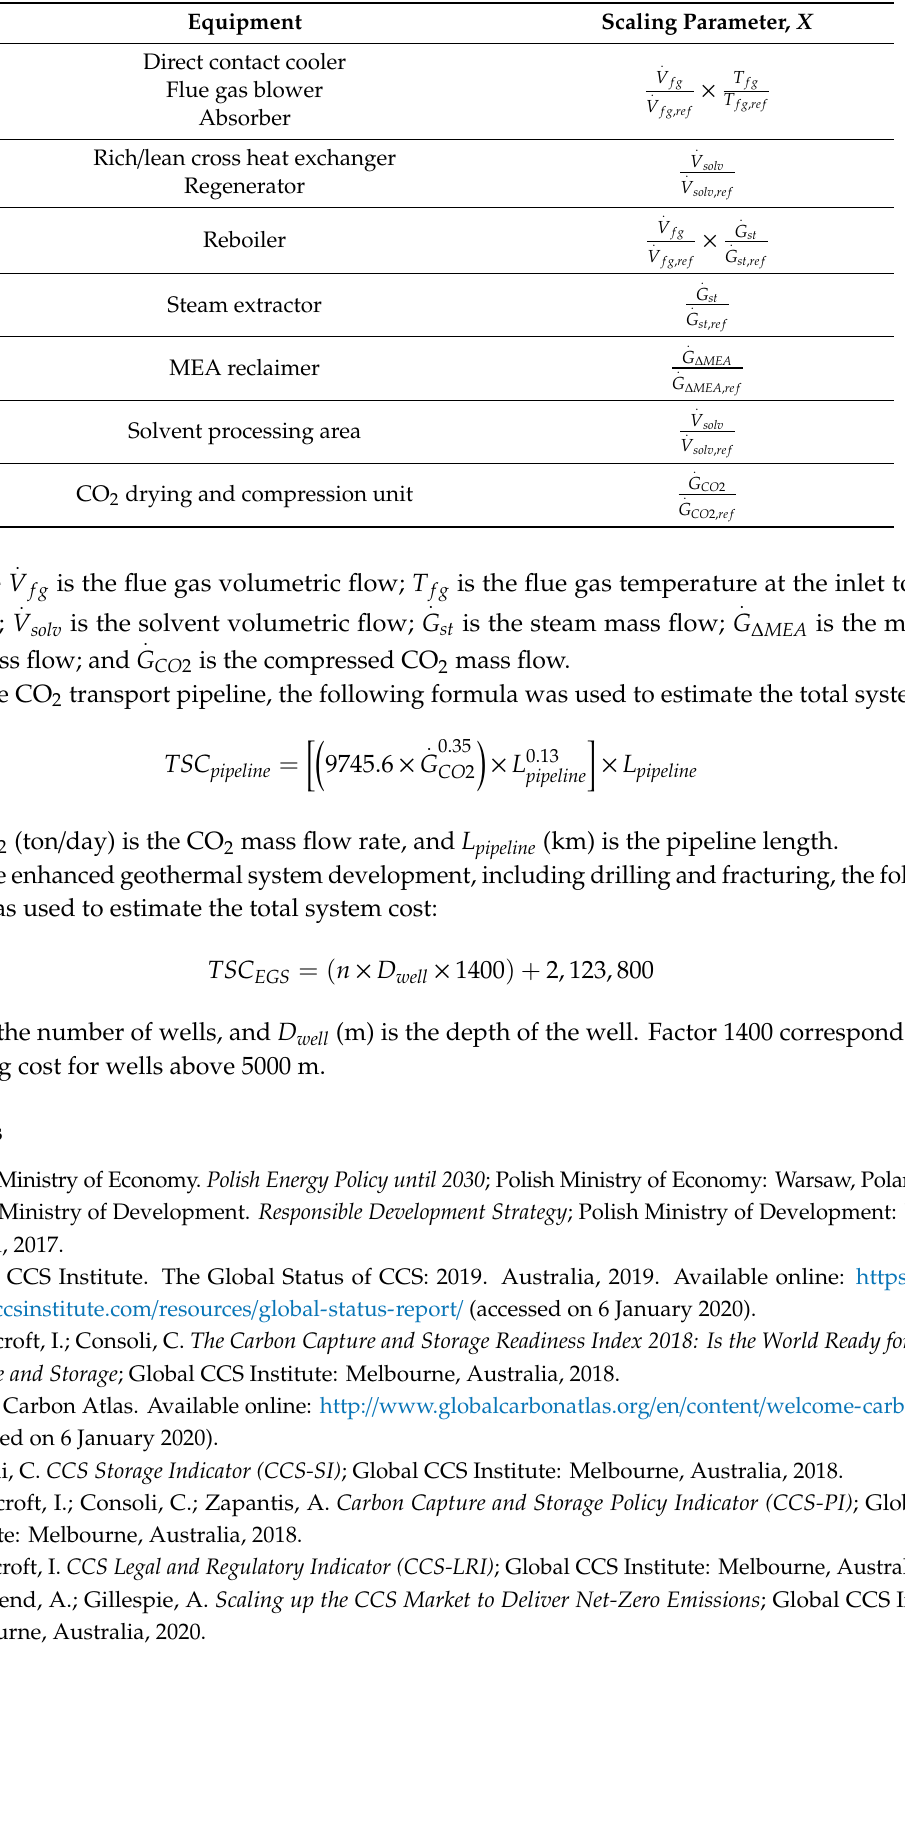
Table A1. Scaling parameters for the CO 2 capture and compression